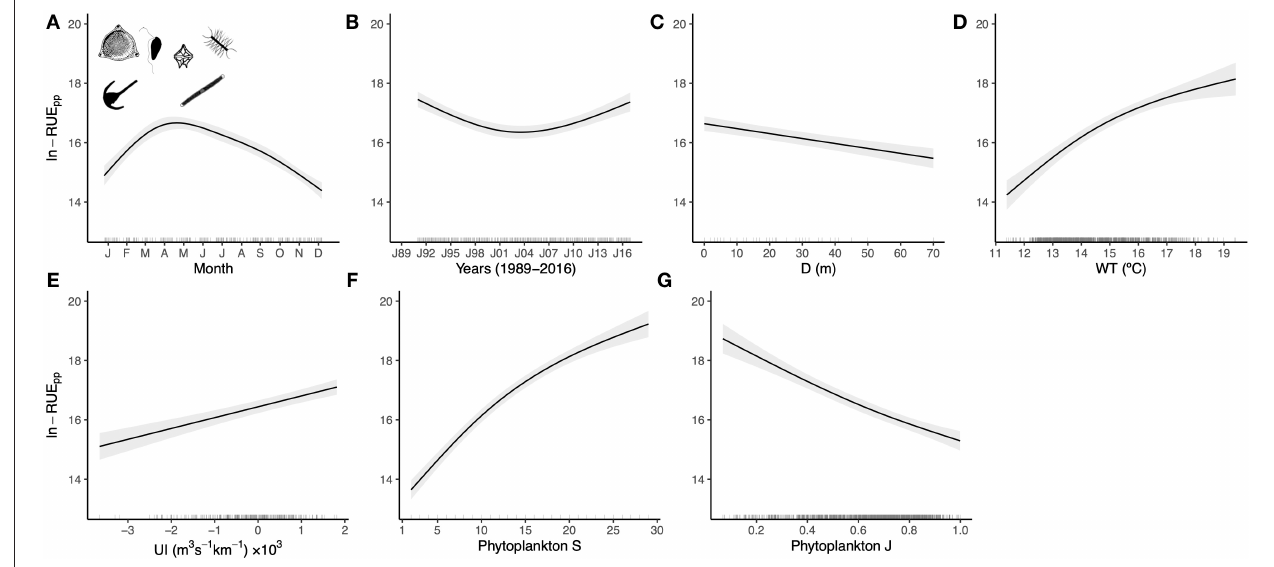
FIGURE 2 | Partial-effects plots from the RUE pp GLS model depicted in Equation (1). Shown are the seasonal (A) and long-term (B) changes in RUE pp , the trend with depth (C) , and the relationships with water temperature (D) , upwelling index (E) , phytoplankton richness (F) , and phytoplankton evenness (G) . Bands indicate 95% confidence intervals and the rugs along the x-axes display the distribution of the data. See ANOVA table in Supplementary Table 2 and model selection of variance covariates in Supplementary Table 3 . Silhouettes were obtained from